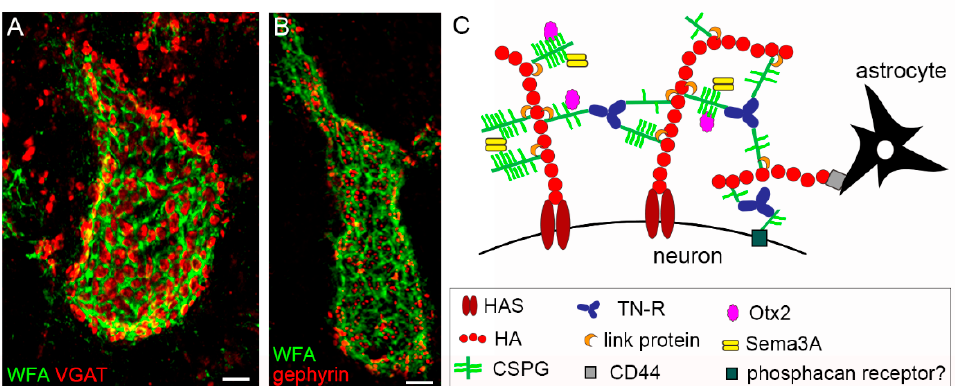
Figure 1. Structure and composition of the PNN. ( A ) and ( B ) show PNNs around neurons in the mouse cerebellar nuclei, labelled by Wisteria floribunda agglutinin (WFA), in green. PNNs display their typical holes, in which pre-synaptic terminals are contained. In ( A ), GABAergic terminals are shown (in red), labelled by anti-VGAT antibodies. In ( B ), post-synaptic clusters of gephyrin, which anchors GABA receptors to the underlying cytoskeleton, are shown (in red). In ( C ), the main molecular components of PNNs are depicted. Scale bar: 4 µm in A and B.